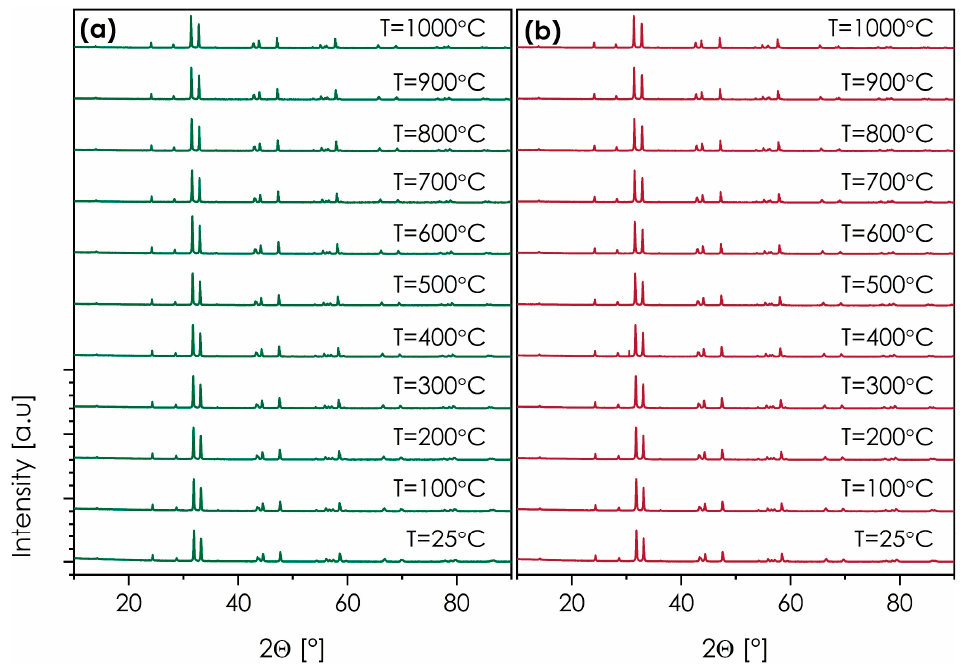
Figure 7. HT-XRD diffractograms (cooling run) measured for: ( a ) SmSr(Co,Fe,Ga,Mn,Ni)O 4+ δ ; ( b ) NdSr(Co,Fe,Ga,Mn,Ni)O 4+ δ .